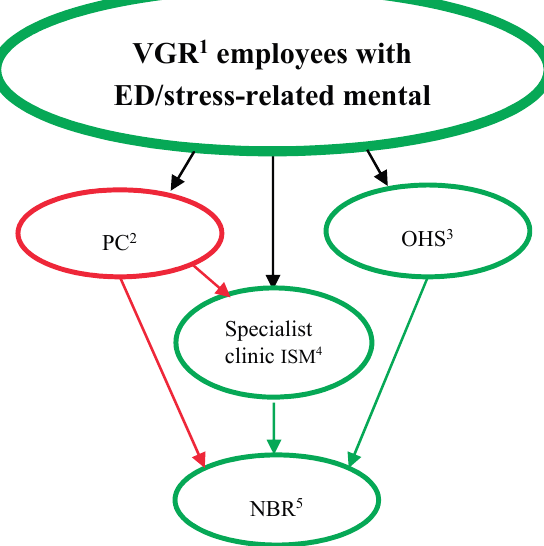
Figure 1. Referral to the NBR of patients with stress-related mental disorders. Green lines indicate activities directly within VGR 1 . Notes: VGR 1 = Region Västra Götaland; PC 2 = Primary care service; OHS 3 = the VGR Occupational health service; ISM 4 = Institute of Stress Medicine, VGR.; NBR 5 = the Nature-Based Rehabilitation started by